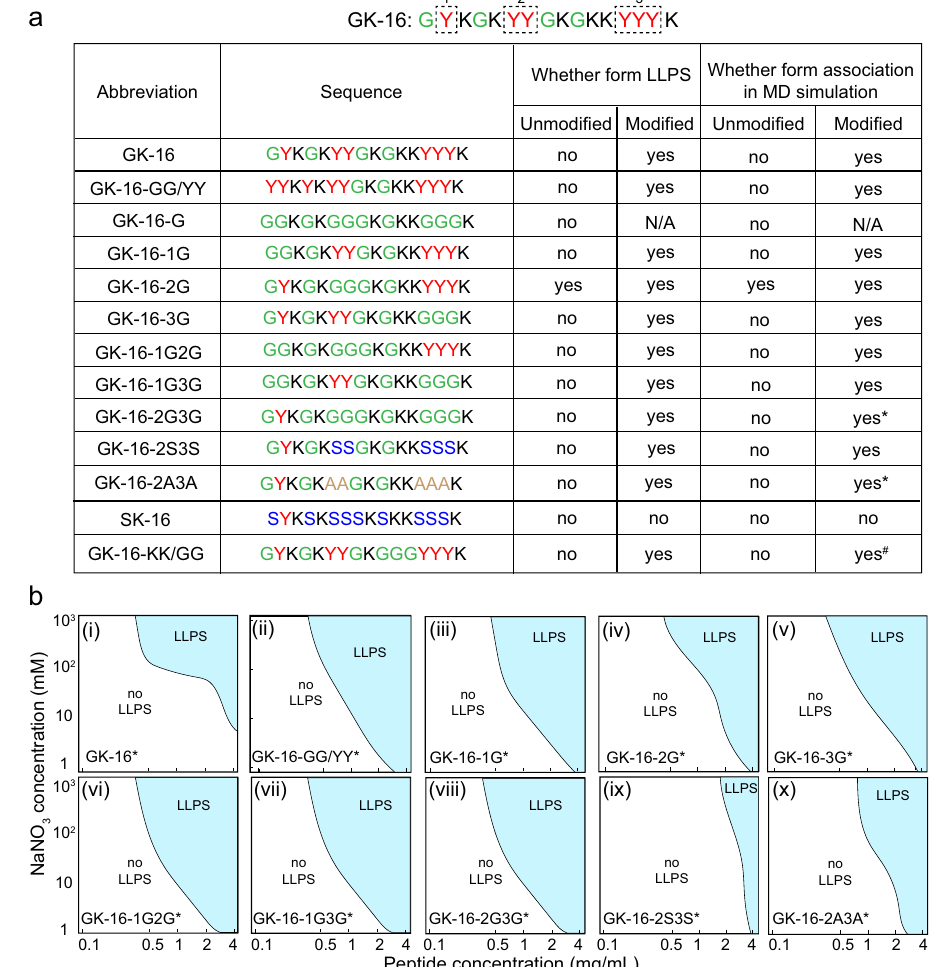
capture the difference. b Phase diagrams of GK-16* variants: (i) GK-16*; (ii) GK-16- GG/YY*; (iii) GK-16-1G*; (iv) GK-16-2G*; (v) GK-16-3G*; (vi) GK-16-1G2G*; (vii)